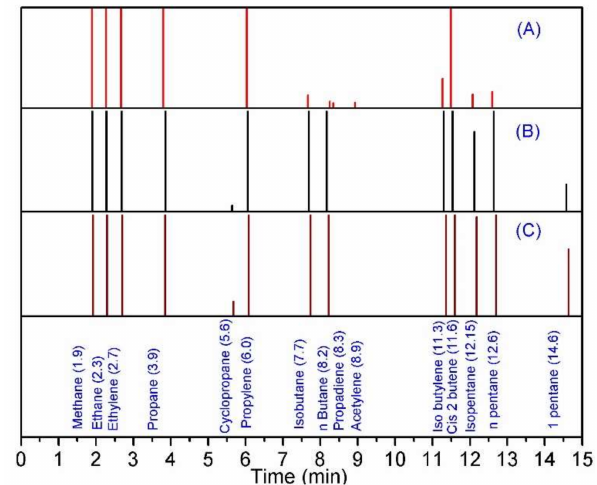
Figure 7. Product profiles obtained from gas chromatograph (GC) analysis: ( A ) propane only, ( B ) butane only, and ( C ) mixed